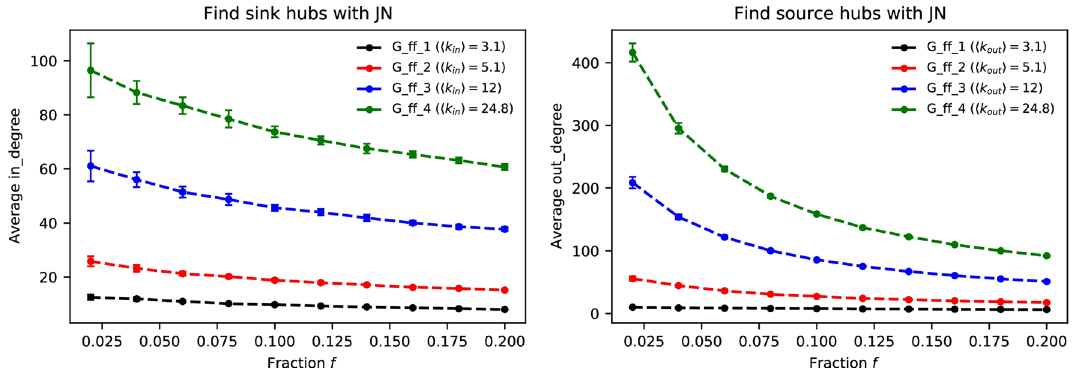
Figure 4. How the network’s average degree affects JN’s performance on finding hubs in directed networks. All of he four generated networks have the 8000 nodes, the average degrees are 3.1, 5.1, 12, 24.8, respectively. JN performs better in the network with higher average degree. The results are averaged over 50 independent runs.